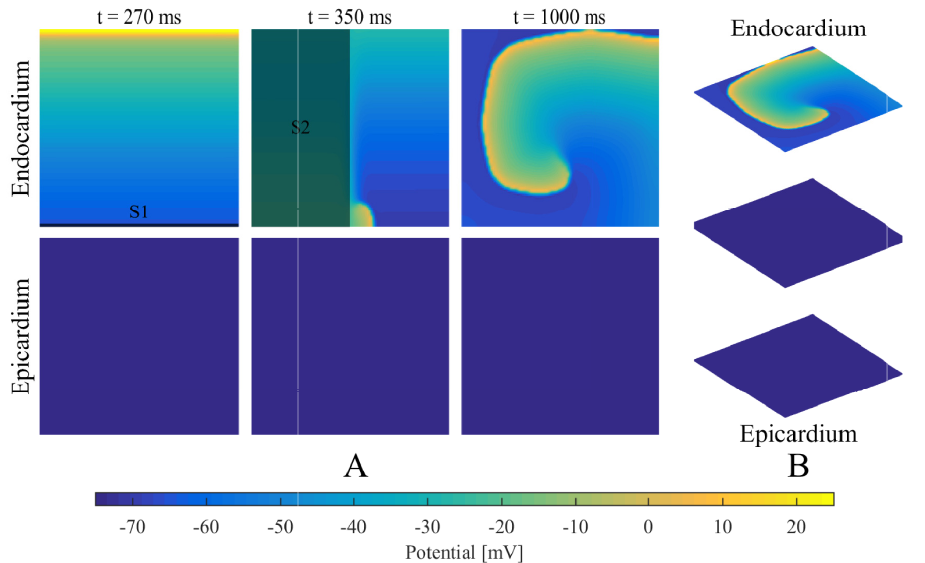
Fig 3. Initial condition using an S1-S2 protocol. (A) The S1–S2 protocol is used to initiate a spiral wave on the endocardium: line stimulus S1 (t = 1 ms) followed by area stimulus S2 (t = 280 ms). (2) The initial condition for the